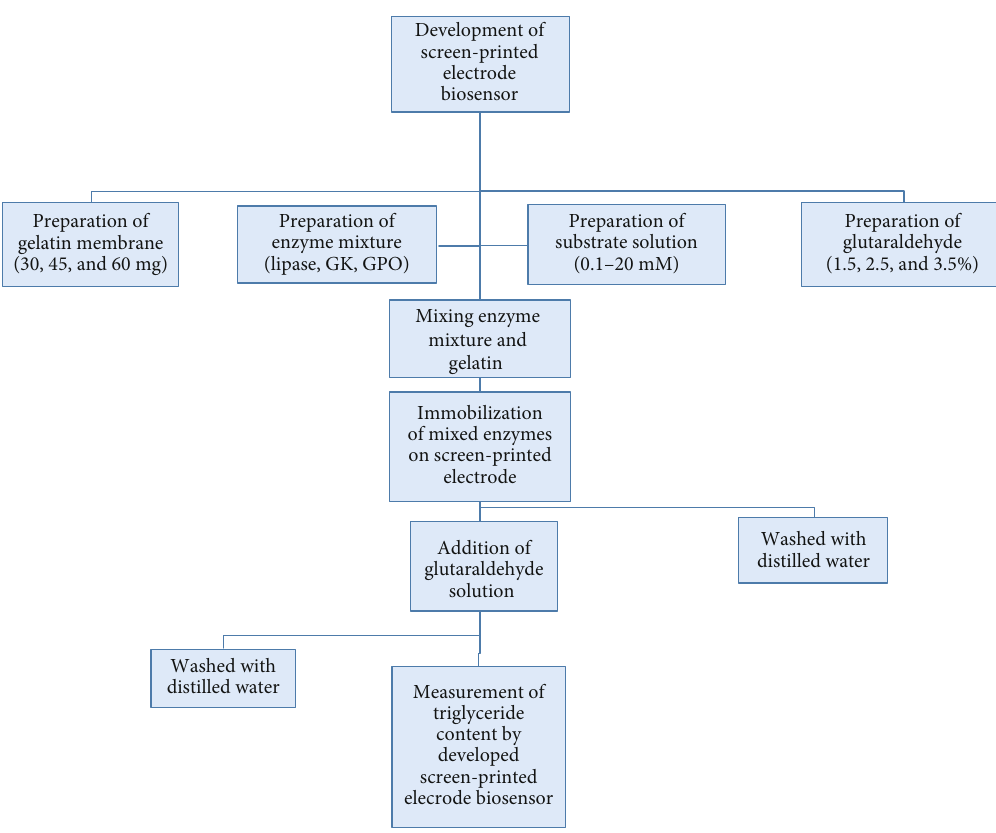
Figure 1: Process fl owchart for the development of the screen-printed electrode